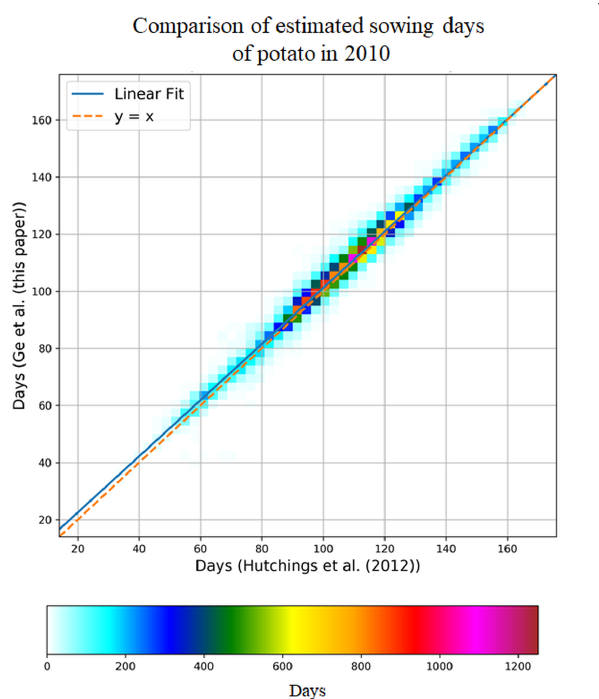
Figure E1. The density plot comparing sowing day estimates of potato between 1985 and 1995 by Hutchings et al. (2012) ( x axis) and in this study ( y